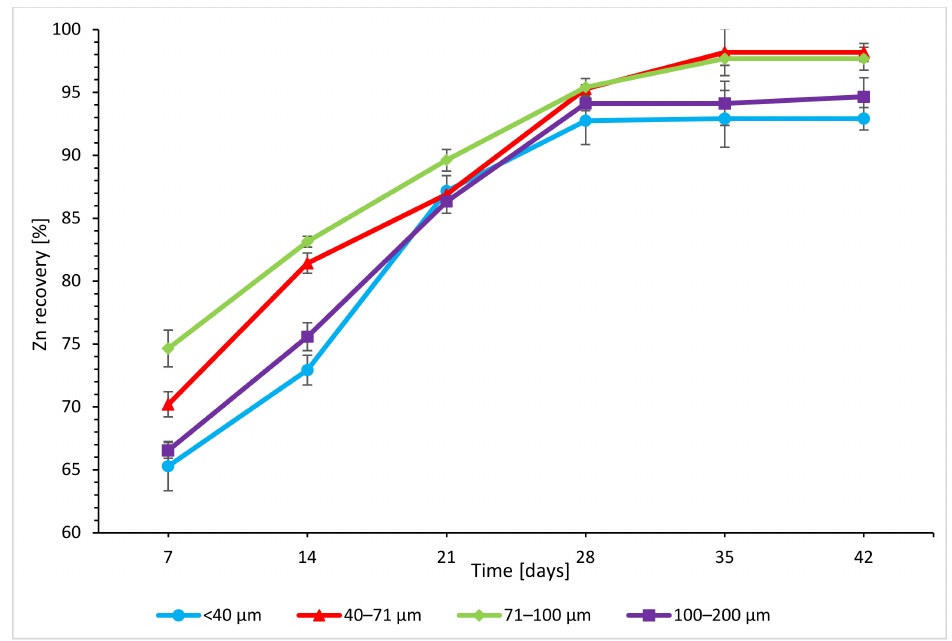
Figure 9. Influence of particle size on Zn recovery (pH 2, stirring speed 100 rpm, and 6.67% ( w / v ) pulp